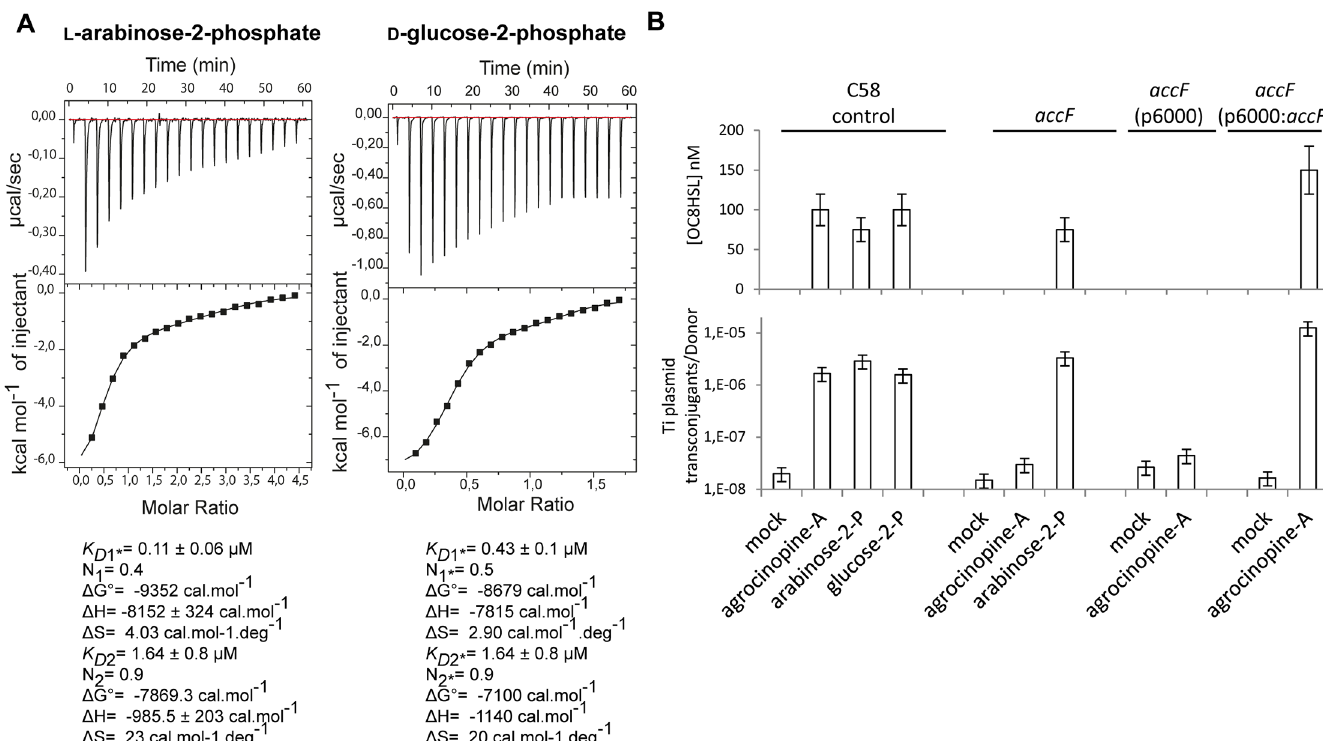
Fig 6. (A) AccR microcalorimetry measurements. The top panels show heat differences upon injection of ligand (L-arabinose-2-phosphate on the left and D- glucose-2-phosphate on the right) and lower panels show integrated heats of injection and the best fit (solid line) using Microcal Origin. Fitting values are indicated below. (B) Quantification of OC8HSL production and Ti plasmid conjugation induced by agrocinopine A, L-arabinose-2-phosphate and D-glucose- 2-phosphate. Different A . tumefaciens C58 backgrounds were used as donor cells: C58 control, accF mutant, accF mutant complemented with p6000: accF wild type and accF mutant complemented with empty p6000). Results were obtained after 72 h of culture. SDs correspond to physical replicates. Experiments independently repeated between two and four times produce similar